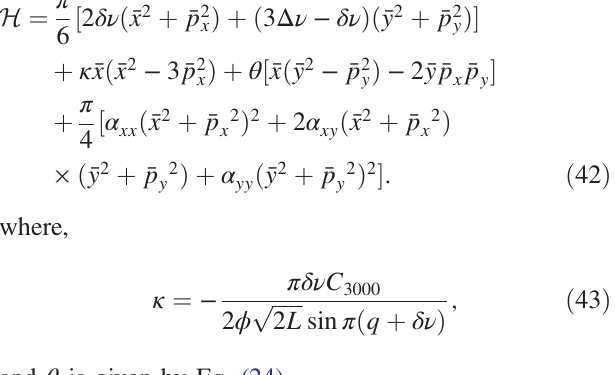
and near the sum resonance: ν x